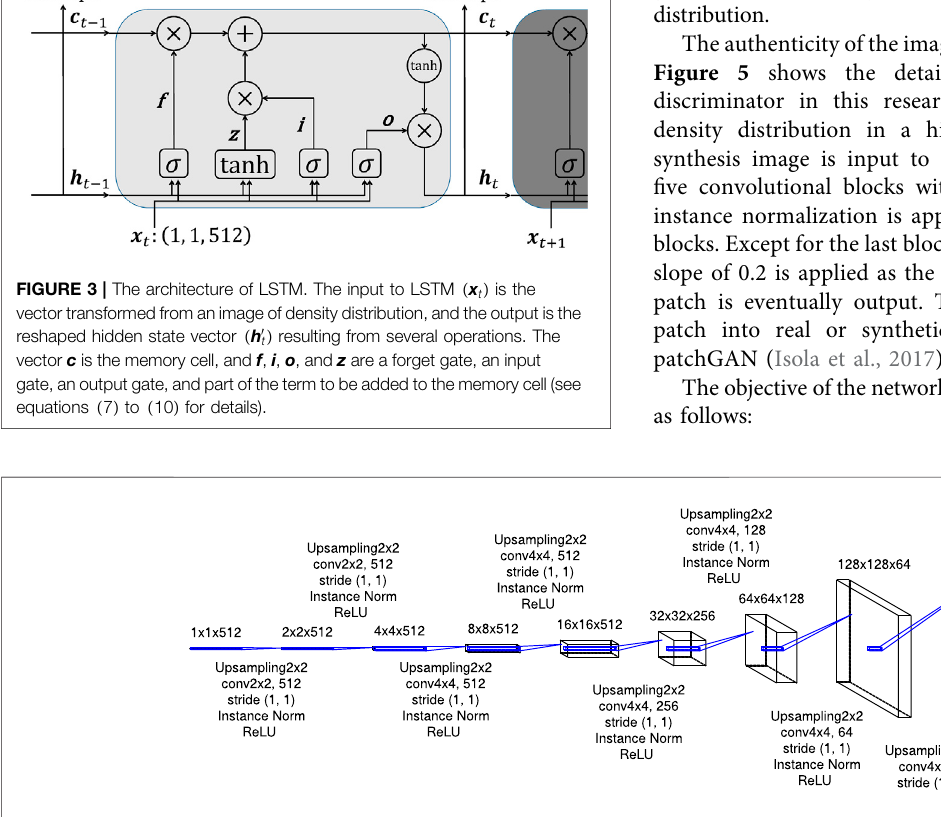
FIGURE4| Thedetailsofthelatter-halfofU-Net.Theexpression “ Upsampling2x2 ” referstoanupsamplinglayerthatdoublesthesizeofinputbycopyingonevalue twice horizontallyand vertically, respectively.From the fi rst-half ofU-Net displayed in Figure 2 ,featuremaps arepassedtocorrespondingblocks and are concatenated to the feature maps output from the previous blocks.